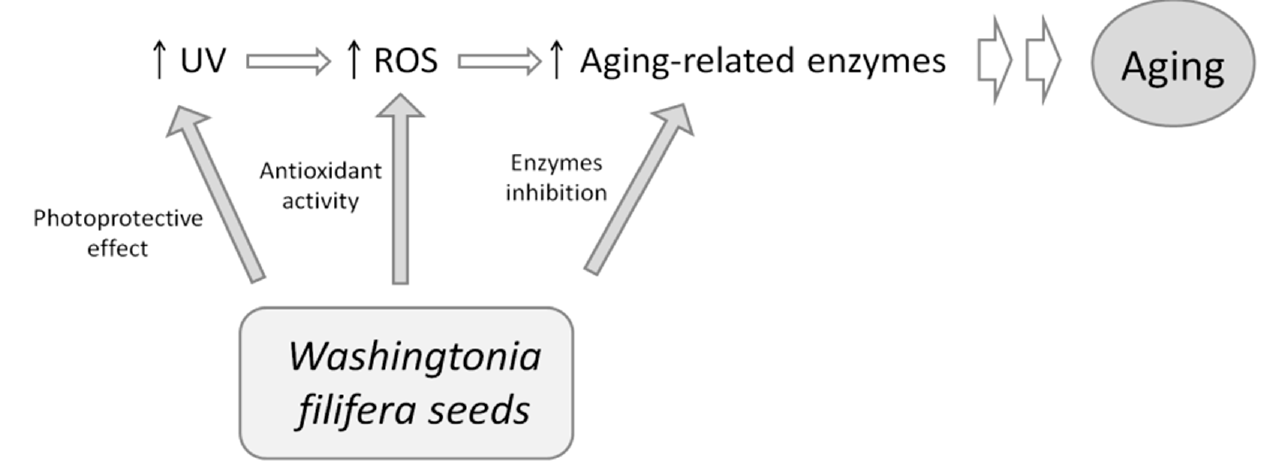
Figure 6. Effect of W. filifera seed extracts on aging